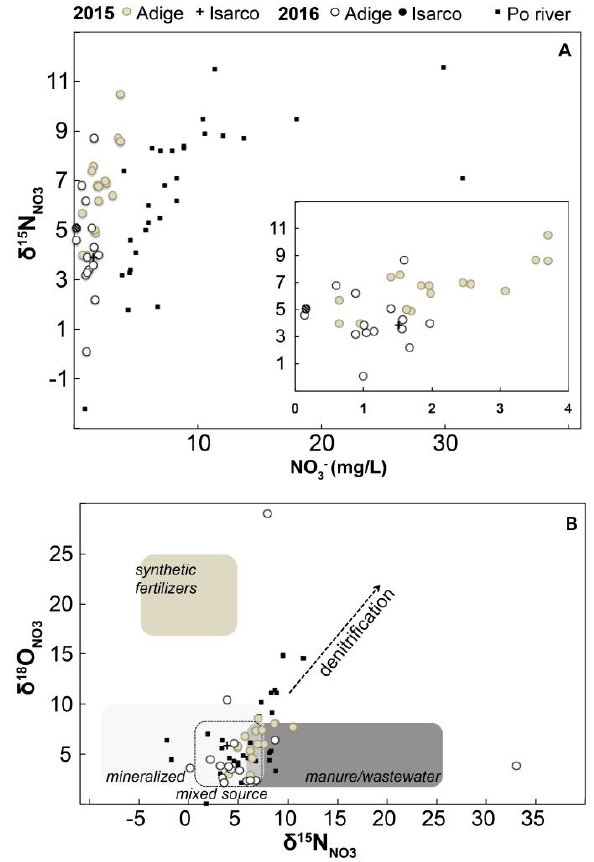
Figure 6. ( A ) NO 3− and the relative isotopic composition (δ 15 N NO3 ) of Adige river water compared with the Po river water described Marchina et al. [16]. The inset shows the NO 3− and δ 15 N NO3 of only the Adige river in the two different periods; ( B ) δ 15 N NO3 vs. δ 18 O NO3 plot reporting the isotopic value of the samples collected in May 2015 and August 2016 in the Adige river and Isarco tributary. Data are compared with the typical ranges of synthetic fertilizers, manure, wastewaters and soil organic matter [59,60] in order to provide specific information about natural / anthropogenic sources of dissolved